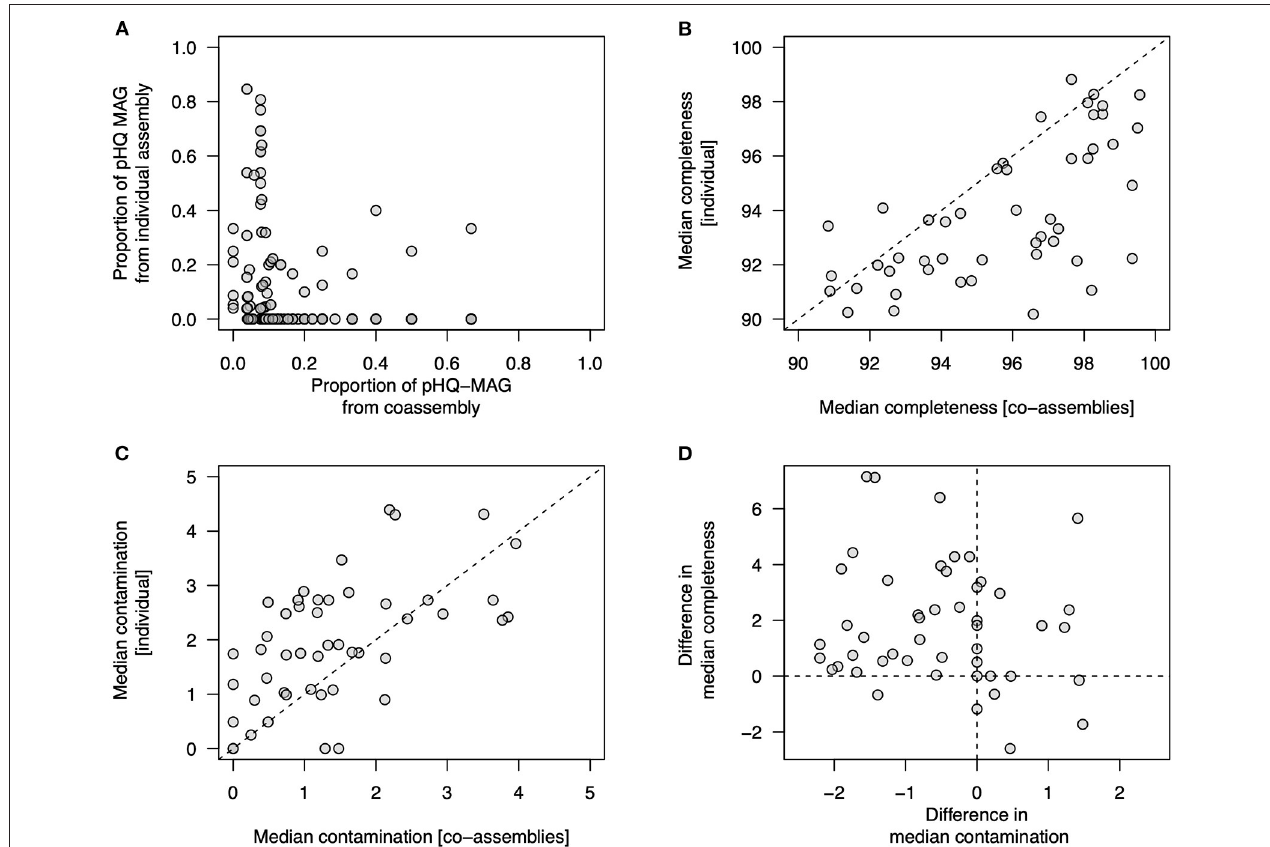
FIGURE 3 | Examination of genome quality in MAGs recovered among different MetaBAT2-derived workflows. Each data point references a secondary cluster of highly related genomes obtained from the dRep workflow. (A) proportion of MAGs within a secondary cluster that attain pHQ quality status from co-assembly workflows ( x -axis) and individual assemblies ( y -axis); (B–D) comparison of genome quality measures from within 48 secondary clusters in which at least one pHQ MAG is observed from a co-assembly workflow and from an individual assembly; (B) median completeness ( C p ) observed from co-assemblies ( x -axis) and individual assemblies ( y -axis); (C) median contamination ( C n ) observed from co-assemblies ( x -axis) and individual assemblies ( y -axis); (D) relationship between the difference in median completeness observed in co-assemblies with respect to individual assemblies ( y -axis) and difference in median contamination (co-assemblies with respect to individual assemblies) ( x